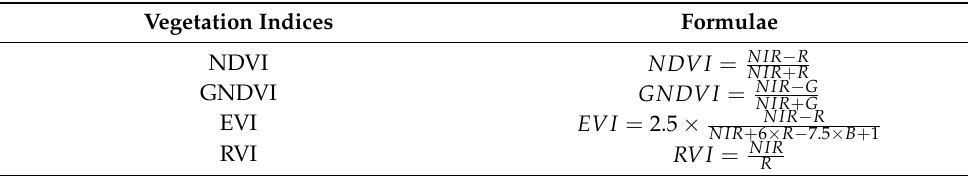
Table 2. Formulae of vegetation indices. Vegetation Indices